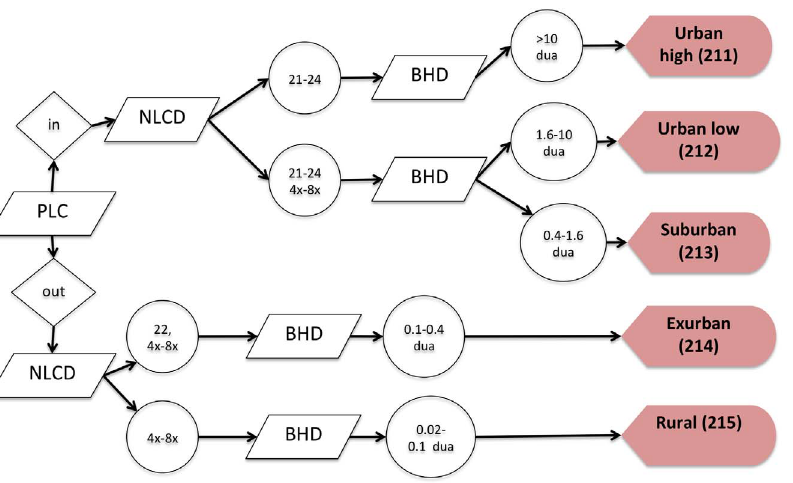
Figure 1. A flow chart depicting the process to map the residential land uses. Locations mapped as high-density urban residential were mapped in the National Land Cover Dataset 2006 (NLCD) as a built-up cover type and had a census block housing density in 2010 (BHD) of at least 10 dwelling units per acre (dua). Low-density urban residential was mapped as within PLC, on land but not water cover types (NLCD water, barren, or wetlands), and had a housing density between 1.6 and 10 dua. Suburban residential was mapped similar to low-density urban but at a density between 0.4 and 1.6 dua. Low-density residential areas were required to be outside of cities/towns (and were defined using Census places; PLC), and exurban residential had a housing density between 0.1 and 0.4 dua, while rural residential had a housing density between 0.025 and 0.1 dua. identified. These long, linear blocks demarcate transportation, typically interstate corridors and